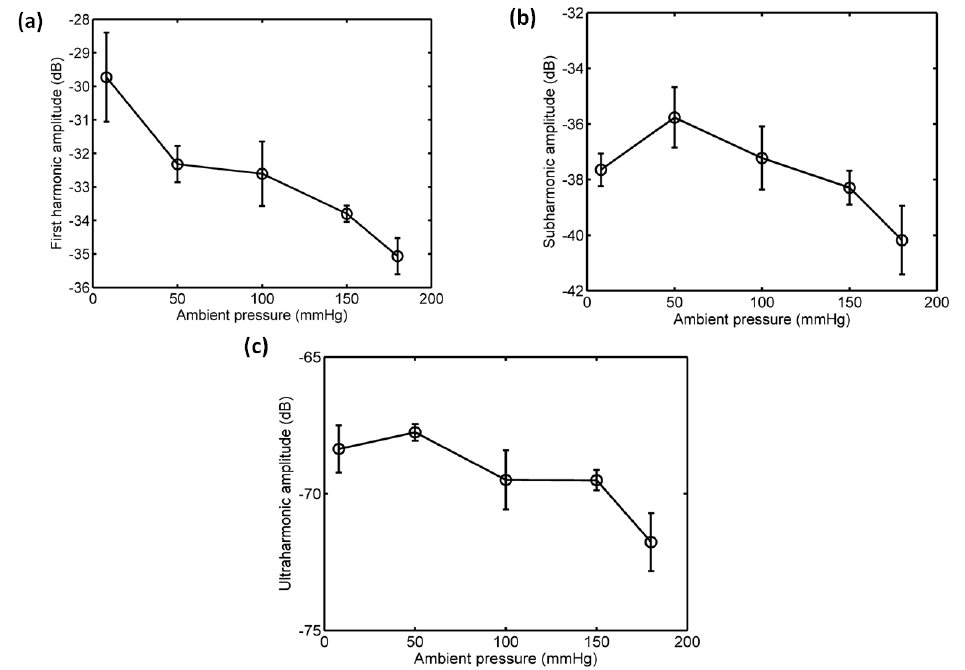
Figure 10. The relationships between the frequency components of the microbubbles’ scattered signals and the overpressure. ( a ) The first harmonic amplitude vs. ambient pressure, ( b ) the subharmonic amplitude vs. ambient pressure, and ( c ) the ultraharmonic amplitude vs. ambient pressure. The driving frequency was 4 MHz, the acoustic pressure was 350 kPa. The transmitted tone burst with 64 cycles had a PRF of 1 kHz.